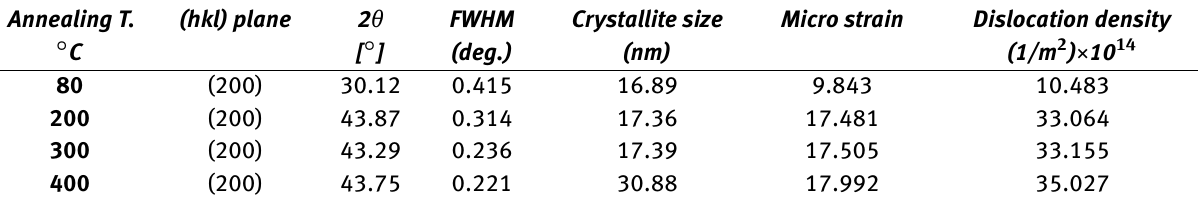
Table 1: XRD result and structural parameters for TiO films prepared by thermal evaporation under a vacuum Annealing T. ∘